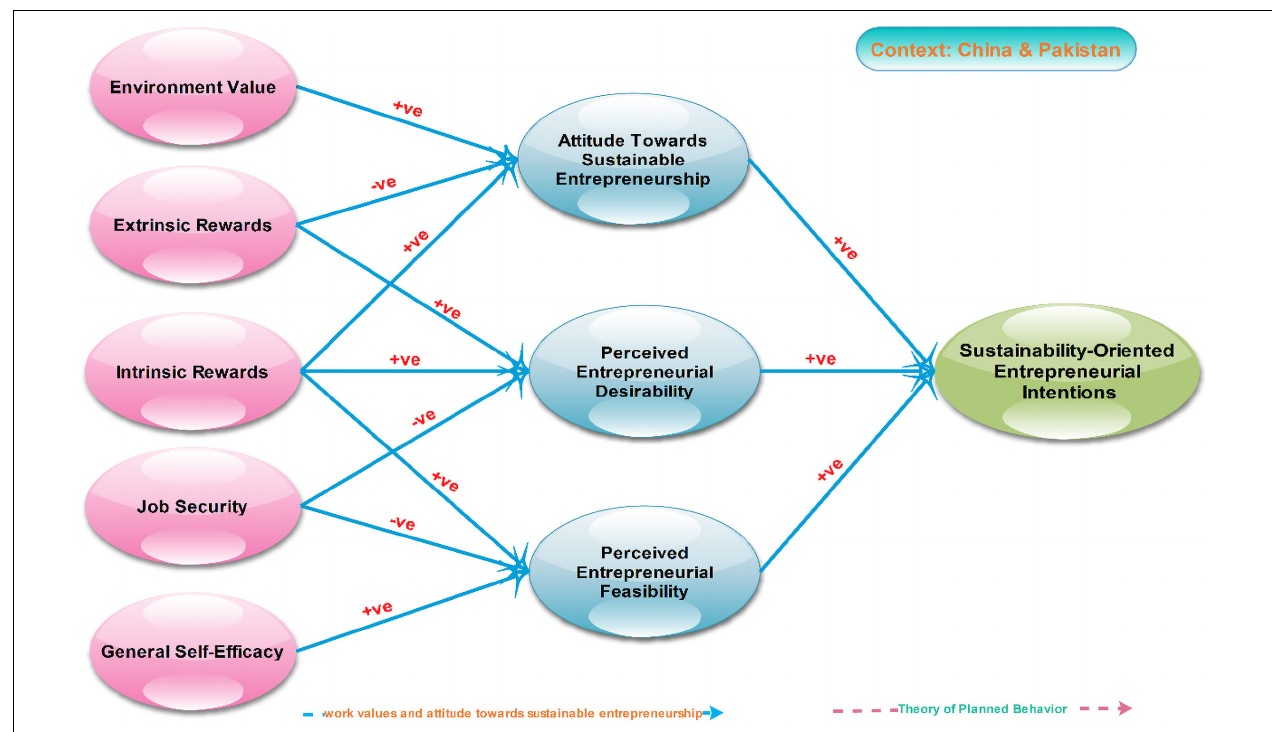
FIGURE 1 | The research framework of the study based on hypothesized constructs adopted form Sher et al. (2020) and Vuorio et al. (2018).